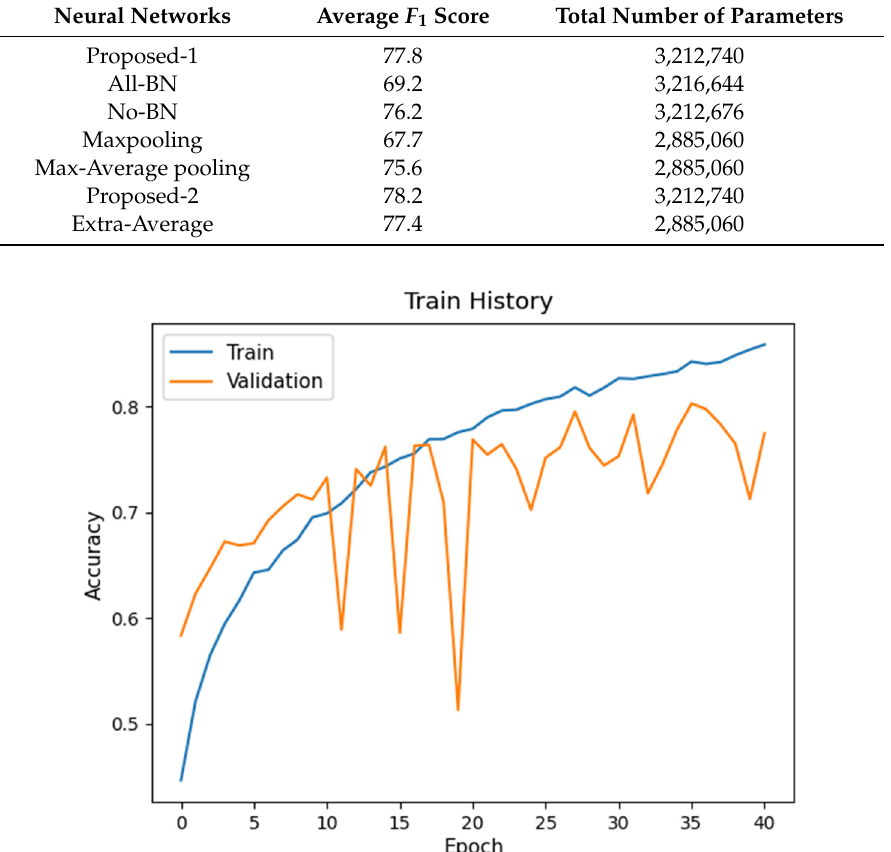
Figure 7. Training accuracy of All-BN.